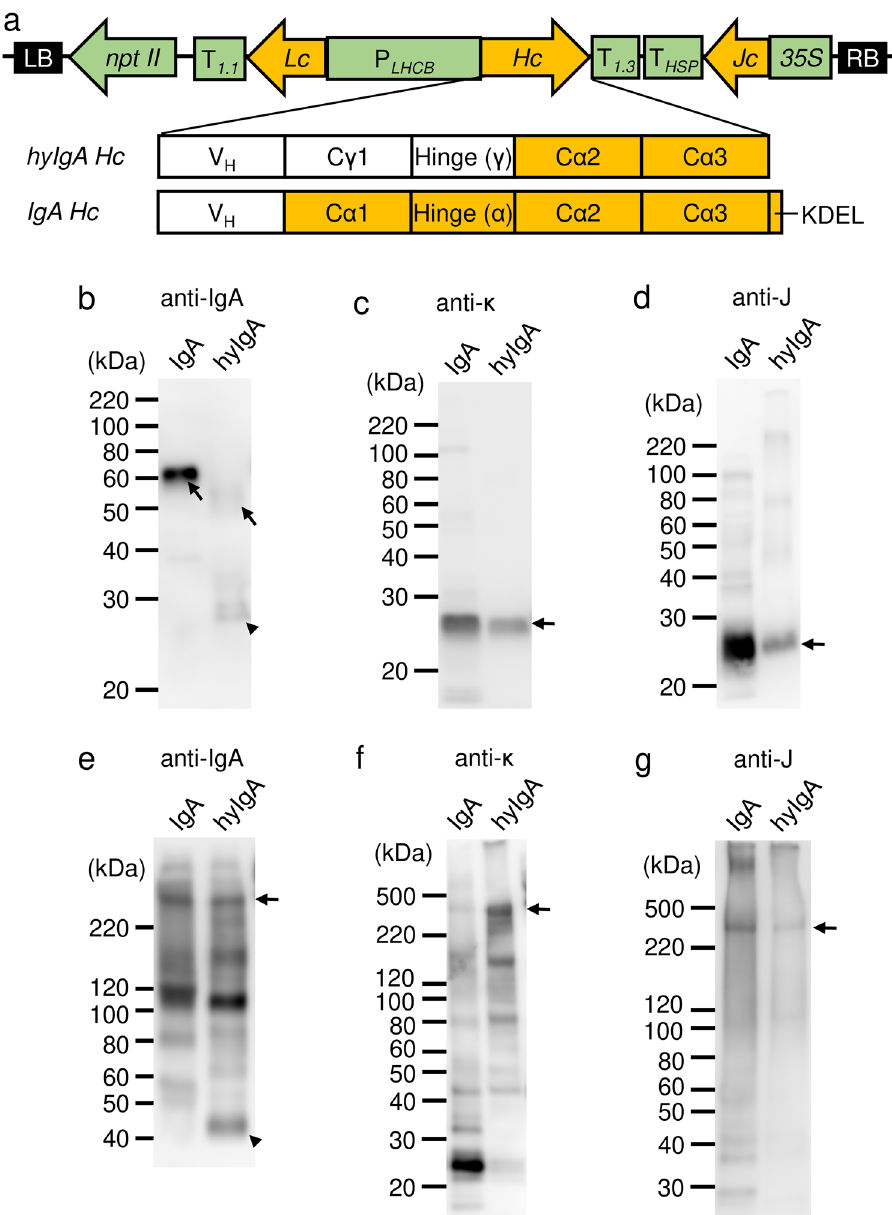
Figure 1. Production of IgA plantibody specific for Stx1B in a plant expression system. ( a ) Schematic diagram of the transfer-DNA (T-DNA) region of the Stx1B-specific dimeric IgA expression vector (pRI201/dimeric IgA). P LHCB , light-harvesting complex II (LHCB) promoter; T 1.1 and T 1.3 , LHCB terminators; Hc , IgA heavy chain gene; Lc , IgA light chain gene; Jc , immunoglobulin joining chain gene; 35S , cauliflower mosaic virus 35S promoter; T HSP , terminator of Arabidopsis heat shock protein 18.2 gene; nptII , neomycin phosphotransferase II gene; LB, left border of T-DNA region; RB, right border of T-DNA region. Immunoglobulin domain organizations of the heavy chain inserts for the hyIgA and IgA are shown in parallel. VH, variable region; Cγ, heavy chain constant regions from IgG1; Cα, those from IgA; Hinge (γ or α), hinge region from IgG1 or IgA; KDEL, the endoplasmic reticulum retention signal peptide. ( b–g ) Immunoblot analysis of leaf extracts of transgenic Arabidopsis thaliana . Leaf proteins ( b,c,e,f , 10 ng/lane as IgA; d,g , 30 ng/lane as IgA) were separated by SDS-PAGE under reducing ( b–d : 12% gel) and non-reducing ( e–g : 4–15% gradient gel) conditions, and then blotted onto PVDF membranes. Each immunoglobulin chain was detected with anti-IgA heavy chain ( b,e ), anti-κ light chain ( c,f ), and anti-J chain ( d,g ) antibodies, respectively. Arrows indicate the intact immunoglobulin chains and arrowheads indicate the incomplete IgA heavy chains. Leaf extracts of Stx1B-specific IgA transgenic A. thaliana (IgA) or hyIgA transgenic A. thaliana (hyIgA) were